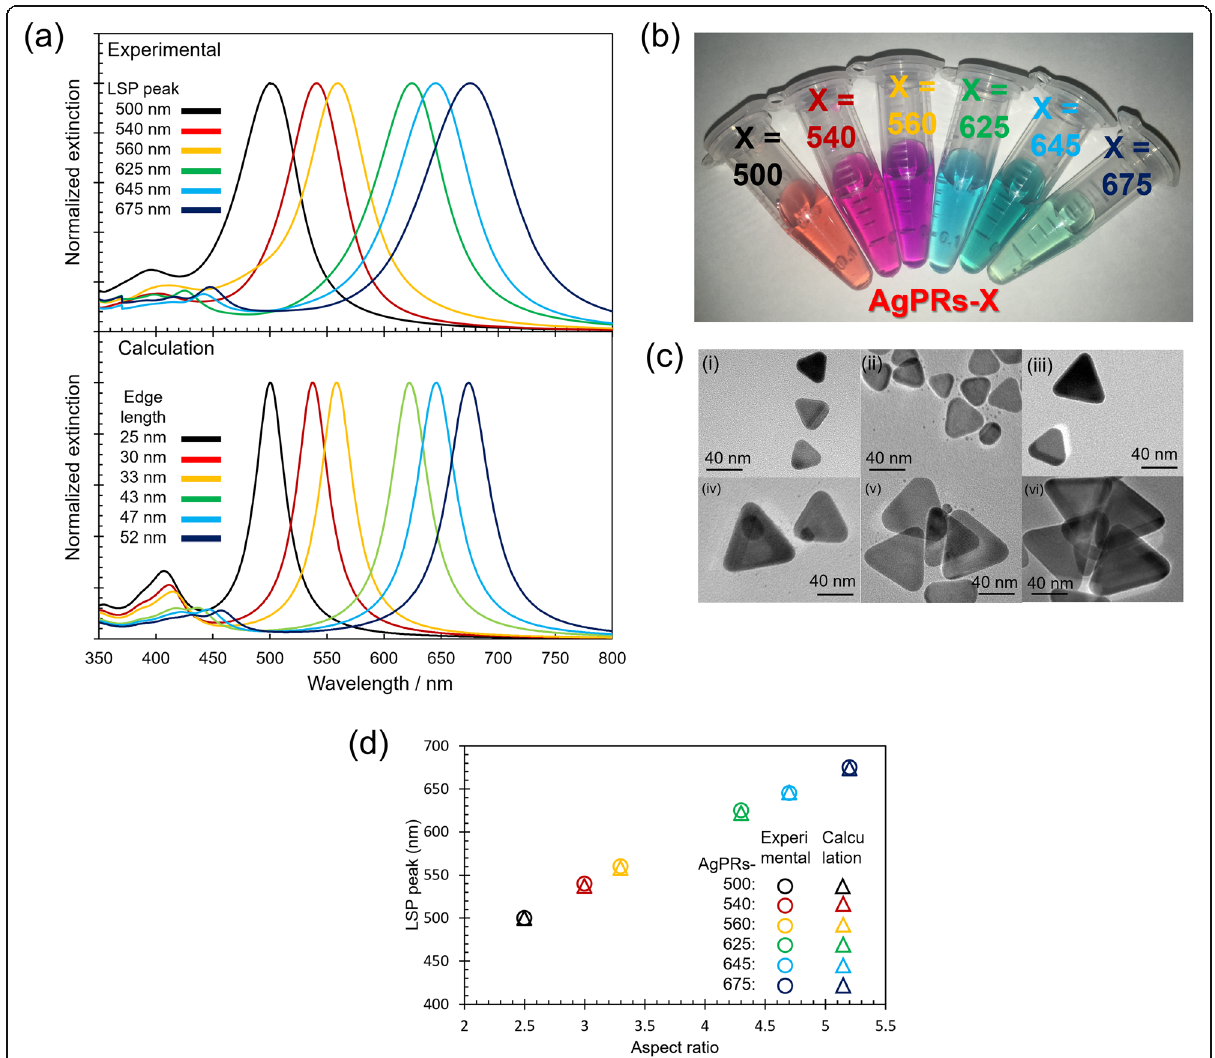
Fig. 2 Characterization of optical property and morphology of AgPRs. a Normalized extinction spectra of aqueous solutions of AgPRs with different LSP peak wavelengths, and normalized extinction spectra calculated by BEM. b Photo image of synthesized AgPRs. c TEM images of various AgPRs (i-vi) synthesized by the modified photochemical methods. d Plots of LSP peaks of AgPRs against their aspect